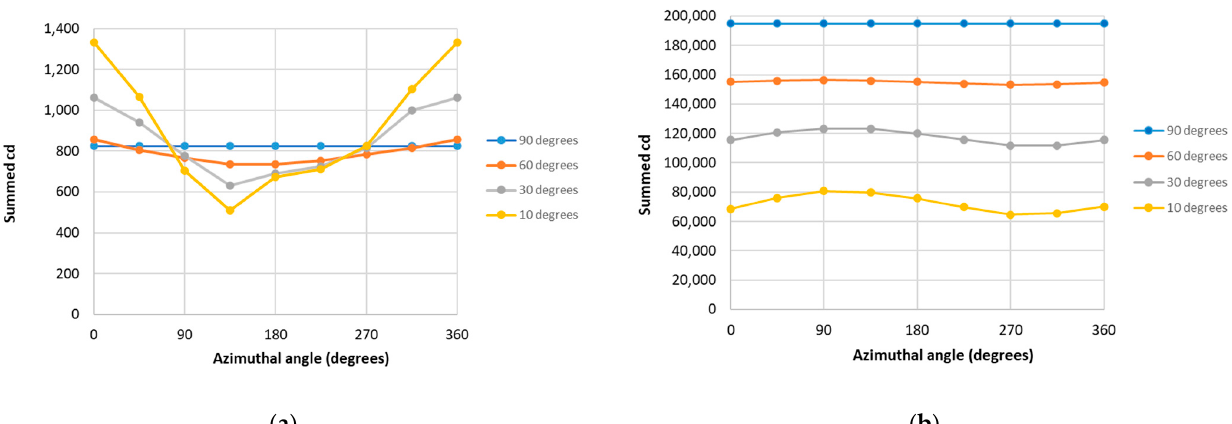
Figure 6. ( a ) The total emission for Ballindangan obtained by summing the diffuse and direct emission. Note that all altitudes have similar emission when seen from due West, but the variations in direct emission cause a larger variation with azimuth, as well as the highest emission at low elevations. ( b ) A similar plot for the Dublin test area showing better behaviour with both altitude and azimuth due to the lower proportion of direct emission.